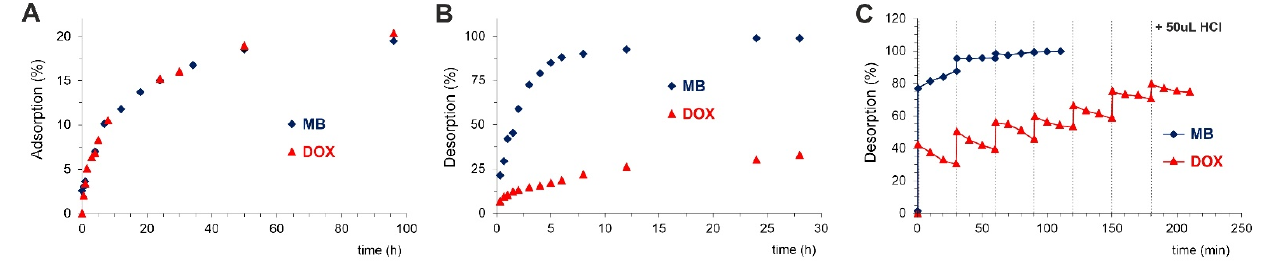
Figure 4. ( A ) Adsorption (at 4 °C) and ( B ) desorption (at 25 °C) of model compounds—methylene blue (MB, blue curves) and doxorubicin (DOX, red curves) from PPF structure, and ( C ) effect of strong acid on the desorption of MB and DOX; note that each vertical dotted line denotes the moment of addition of 50 µL 2 M HCl to the solution.